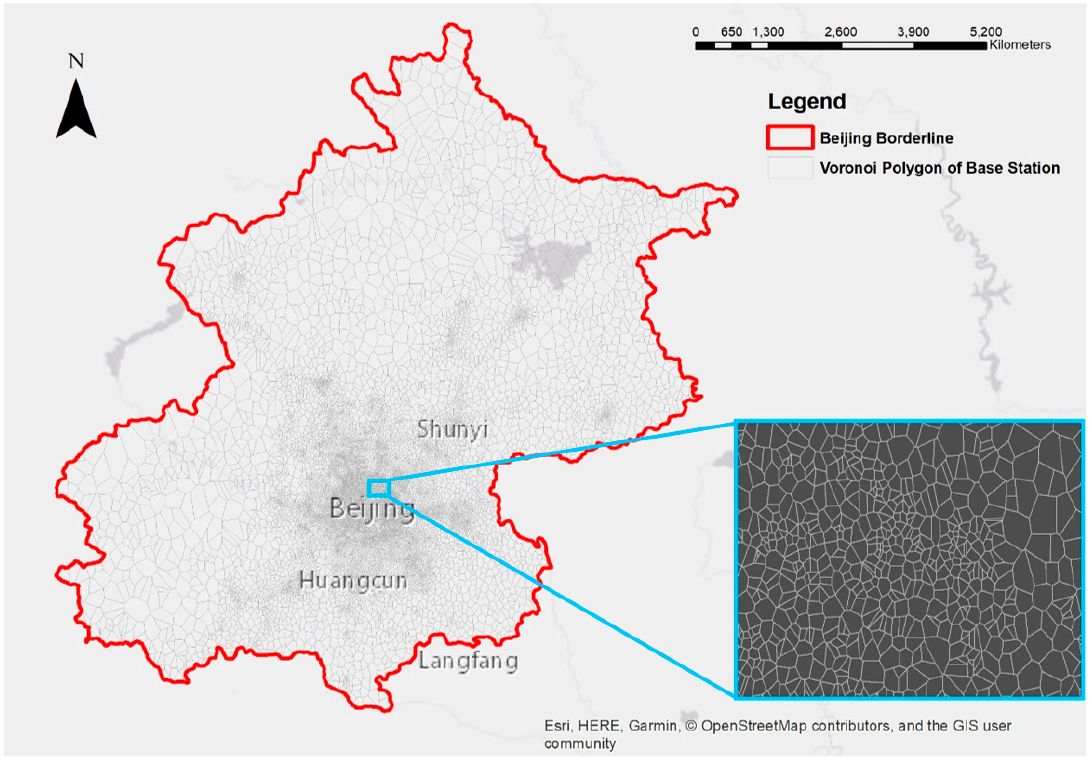
Figure 4. Mobile base stations are represented by Voronoi polygons in Beijing.